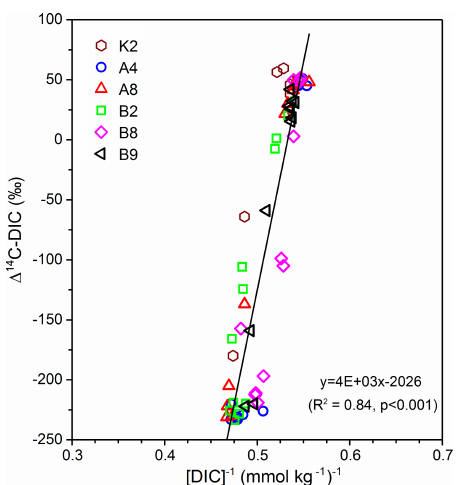
Figure 10. Keeling plot of (cid:49) 14 C-DIC vs. concentration of [DIC] − 1 measured for six stations (B9, B8, A4, A8, B2 and K2) in the north- western North Pacific (data from Ding et al., 2018). The line indi- cates the linear regression fit to all data